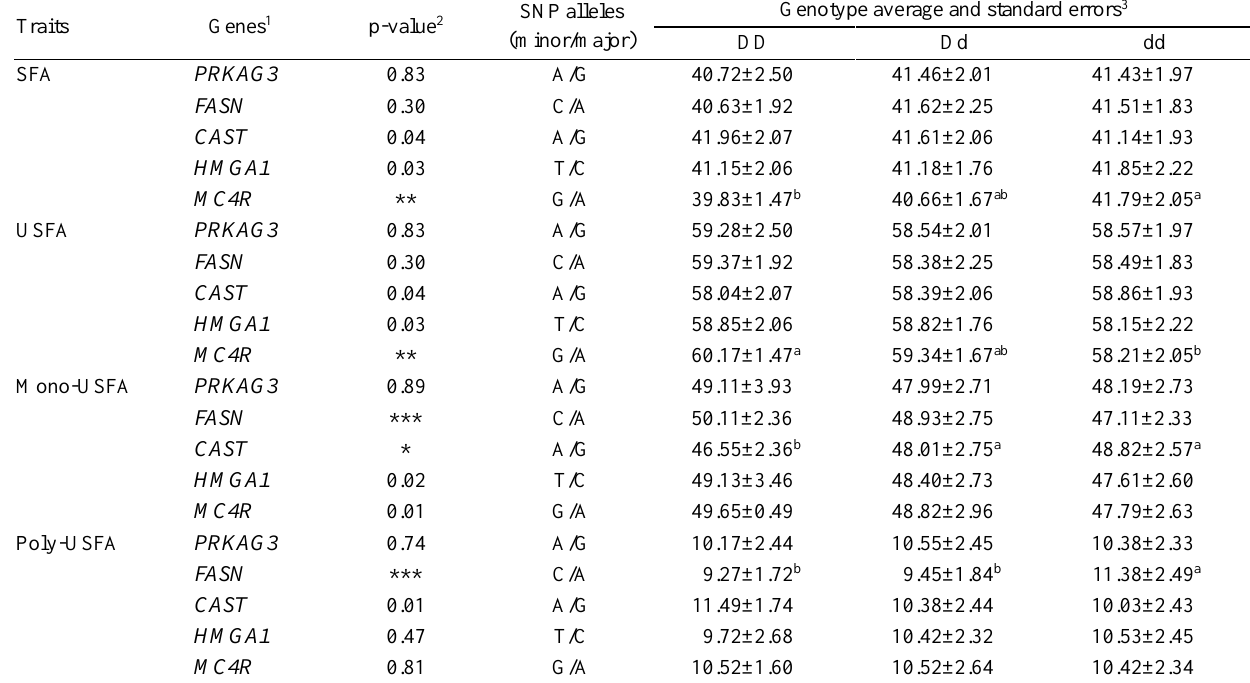
Table 6. ii) Association of SNP genotypes and their harboring genes with fatty acids (%) of LD muscle in Duroc breeding stock